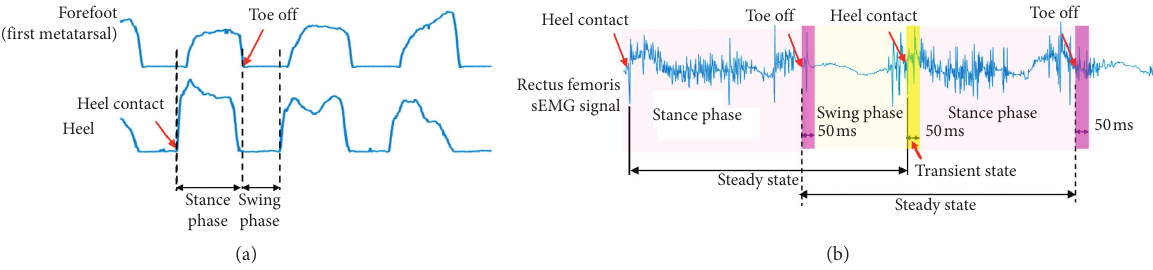
Figure 2: Data processing methods. (a) Gait phase detection by pressure sensors. (b) Sliding window scheme and